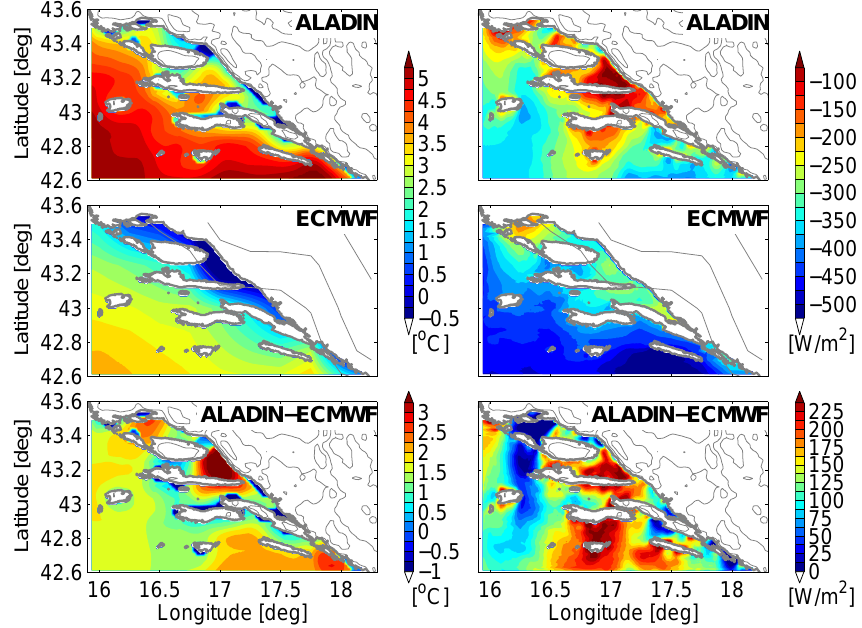
Fig. 5. Mean ALADIN (top panels) and ECMWF (center panels) modeled air-temperature (left panels) and latent heat flux (right panels) for the B2 Bora episode (Table 1). The bottom panels show the differences between respective fields